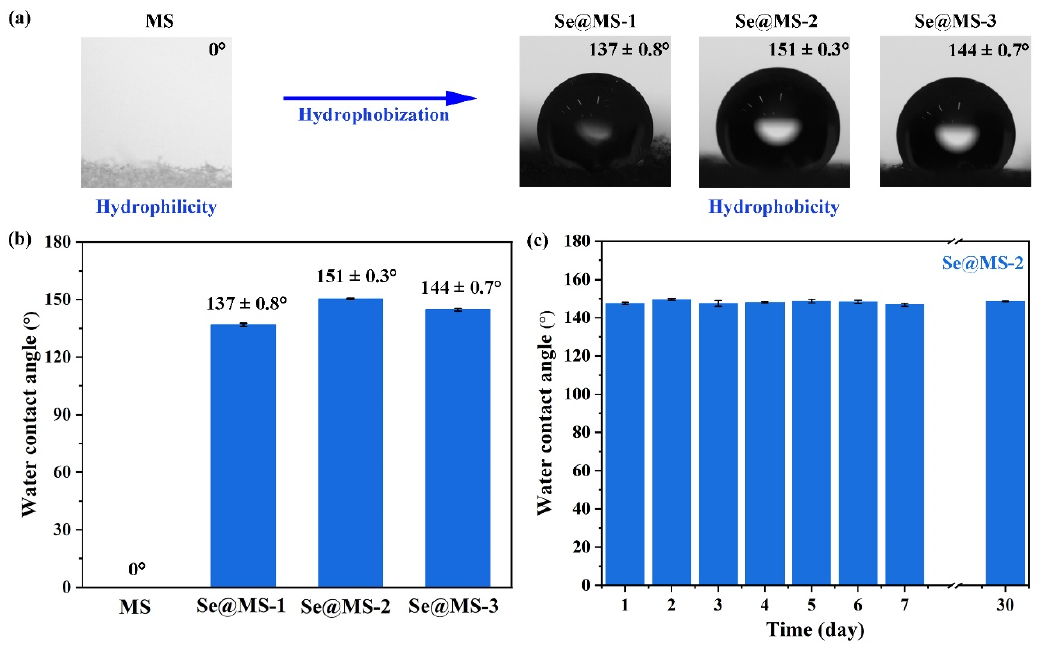
Figure 4. Hydrophobic performance of pristine MS and Se@MS. ( a ) Optical images of the pristine MS, Se@MS-1, Se@MS-2, and Se@MS-3; ( b ) water contact angle of the pristine MS, Se@MS-1, Se@MS-